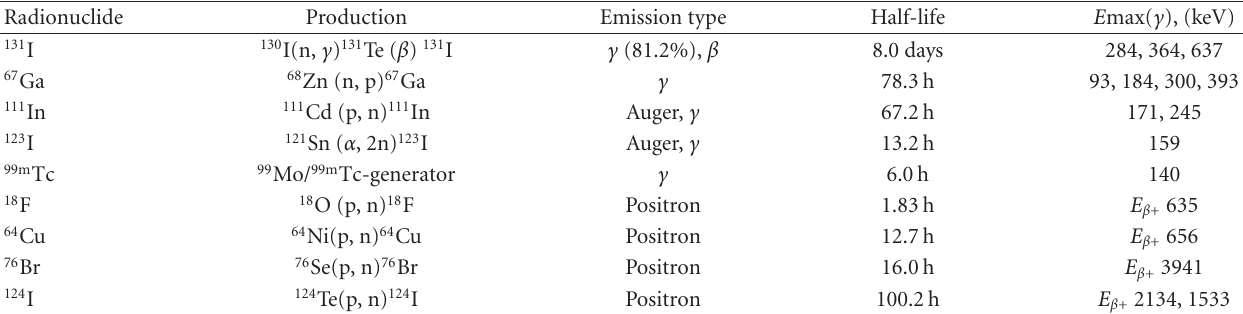
Table 1: Characteristics of potential radionuclides for nanotargeted tumor imaging [20, 21, 28, 29]. Radionuclide